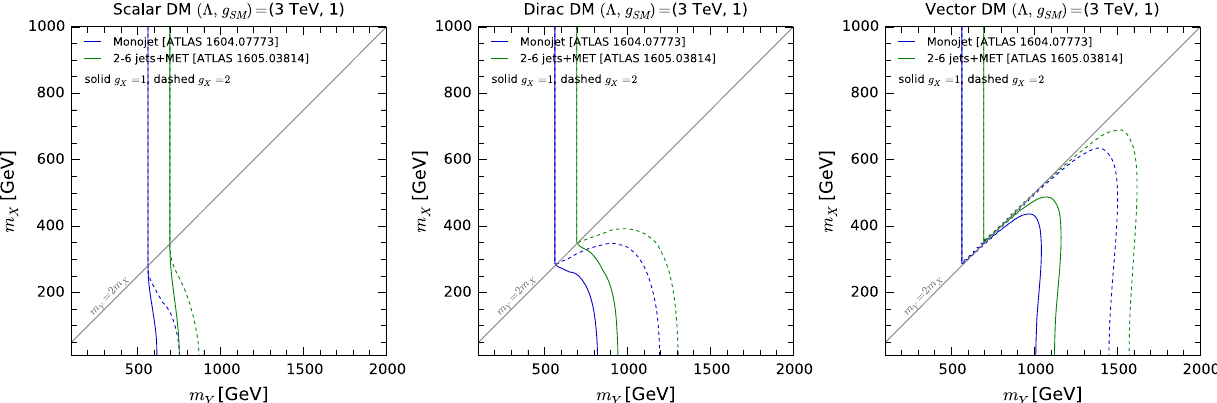
Fig. 5 Ratio of signal events over the number of events excluded at 95% CL as a function of the mediator mass, for g X = 1 or 2 with Λ = 3 TeV, g = 1 and m = 10 GeV, where the ATLAS 13 TeV X SM